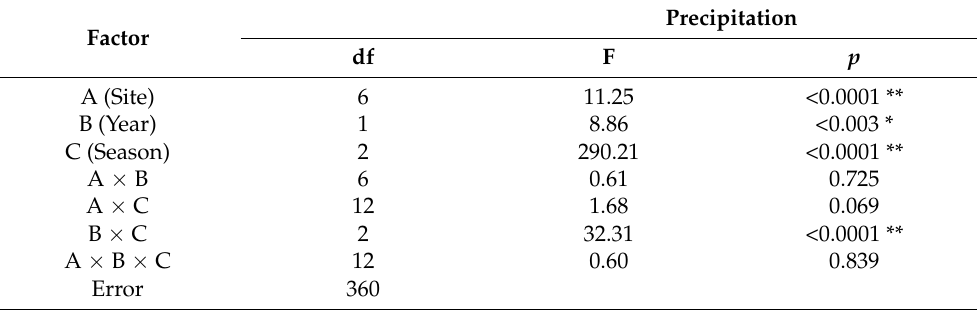
Table 2. Results of a three-factorial repeated-measurement ANOVA on the effects of site (Peten Neyac, R í o Verde, Champot ó n, Sabancuy, Xibuja, Estero Pargo and Atasta), year (2009 and 2010), seasons (dry, rainy and Nortes) and species ( Rhizophora mangle , Avicennia germinans and Laguncularia racemosa ) on the precipitation along the Campeche coast, with a significance level of p < 0.05.